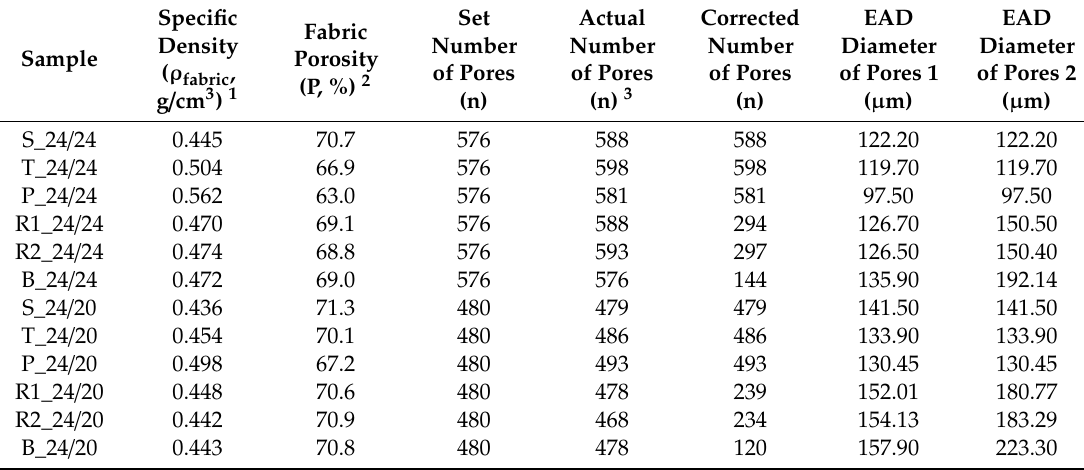
Table 4. Results of measuring physical characteristics of samples.